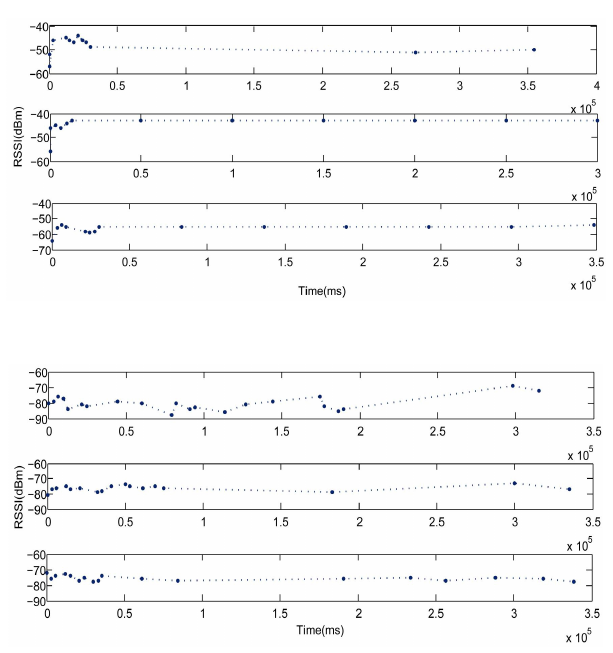
Fig. 5. The framework of the optimization mechanism Figure 6. The framework of the optimization